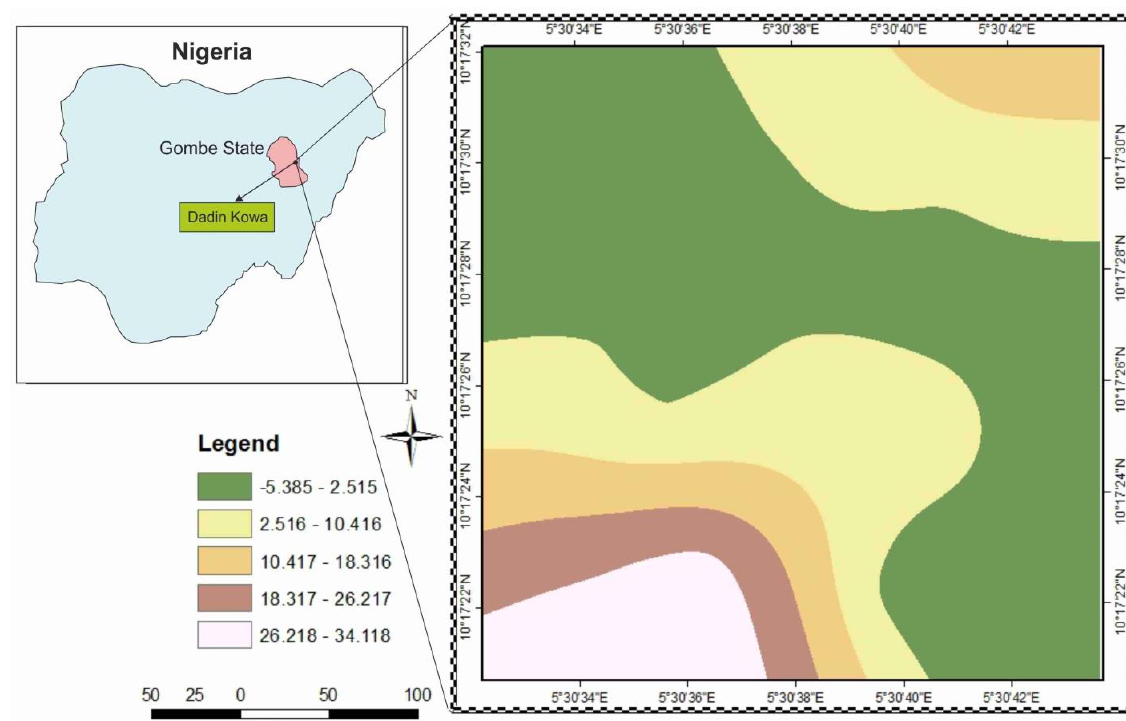
Fig. 7. Hydraulic conductivity across the